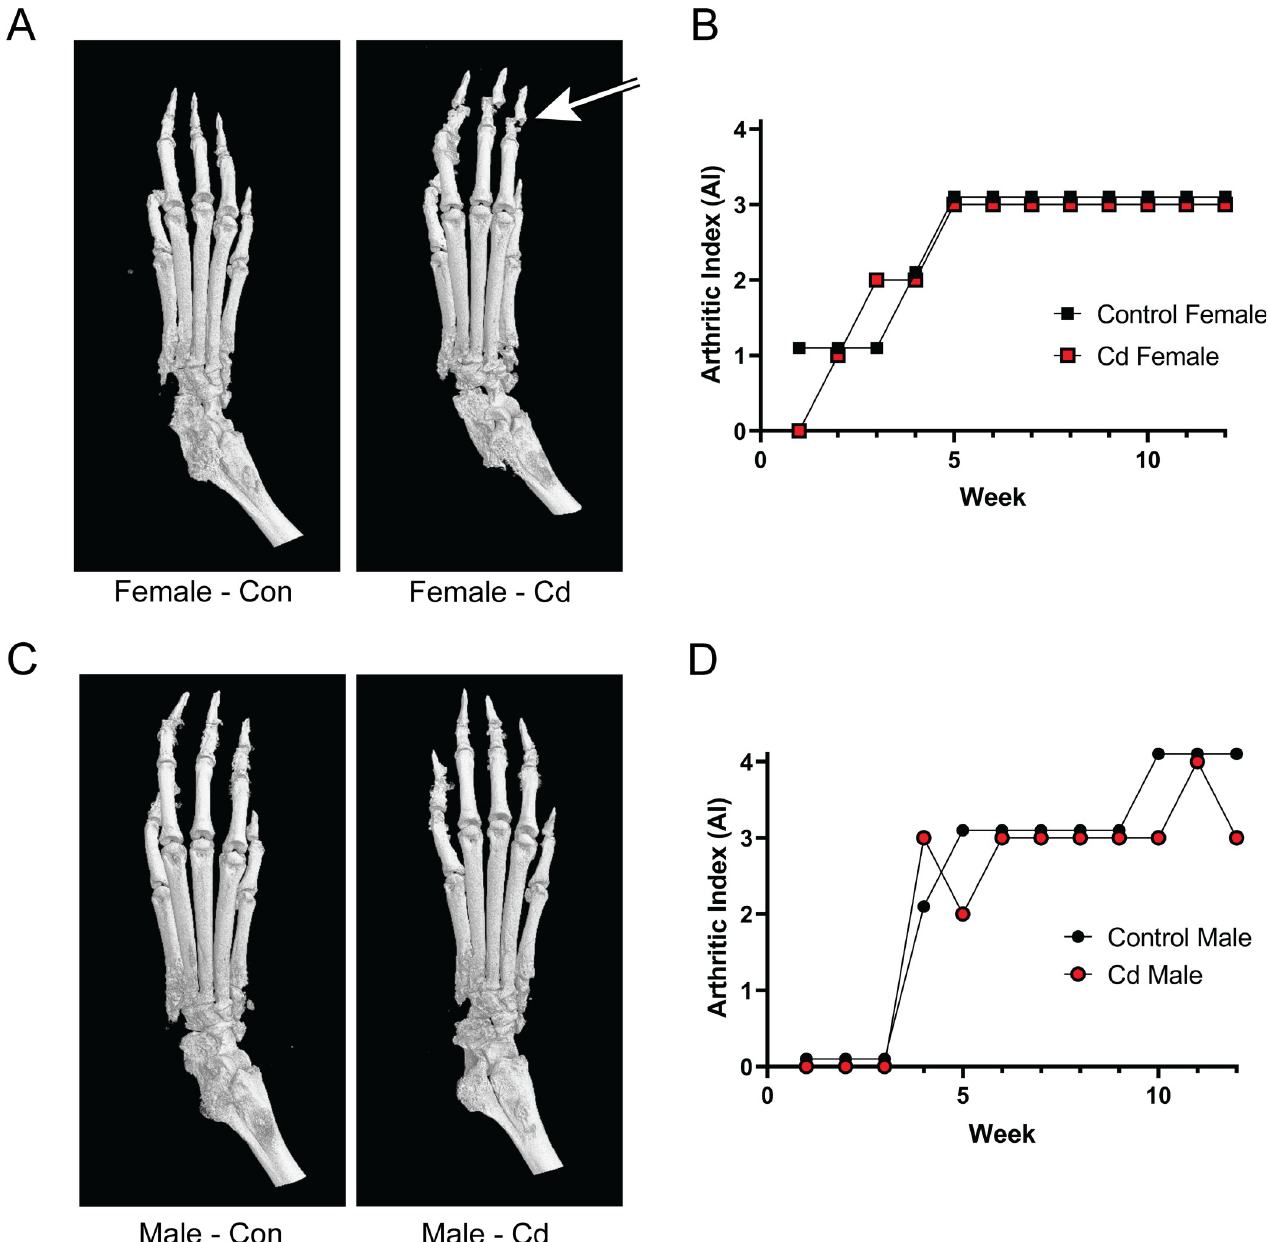
Fig 6. MicroCT analysis of the paws of arthritic Control and Cd-exposed SKG offspring. Dam and sire SKG mice were exposed to cadmium as described. At 8 weeks, the arthritis was induced in the offspring by the injection of zymosan A. Twelve weeks after arthritis induction, the animals were euthanized, and the limbs processed for μ CT analysis. (A & C) Representative μ CT images from rear left paws. Distorted phalanges are indicated by the arrow. (B & D) Arthritic indices for individual paws shown in A & C. No arthritis control values are inidicated by the dotted line. VOI ratio (BS/TV) which quantifies the bone surface density. The Cd females showed a statis- tical difference in the bone volume fraction (BV/TV) and trabecular thickness (Fig 7B)–values that have been deemed crucial for determining the three-dimensional (3D) outcomes for tra- becular bone microarchitecture [36]. The ratio of the segmented bone surface to the seg- mented bone volume (BS/BV; Fig 7) was also statistically different in the female Cd-exposed